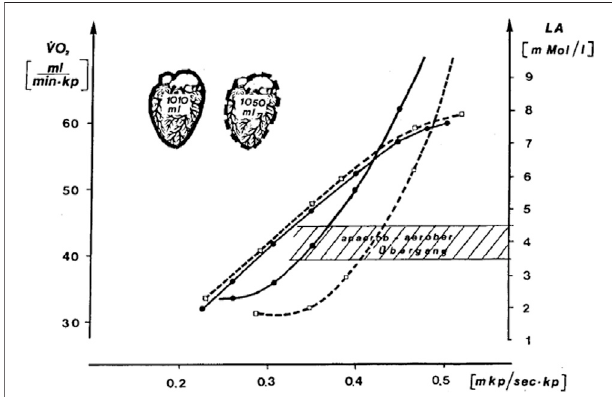
FIGURE 1 | Effect of a ≈ 6-week endurance training by one individual at the intensity of the 4 mmol . L − 1 lactate threshold (Mader et al. termed it “ aerobic-anaerobic transition ” ) on heart volume measured by X-ray, _ VO and the workload at the at 4 mmol . L − 1 lactate threshold. The study also highlightsthattheexerciseprotocol(e.g.,thedurationofeachstep)affectsthe lactate curve and that lactate testing should be speci fi c for each sport (e.g., testing rowers on a treadmill has little predictive power). Printed with kind permission from Mader et al. (1976).